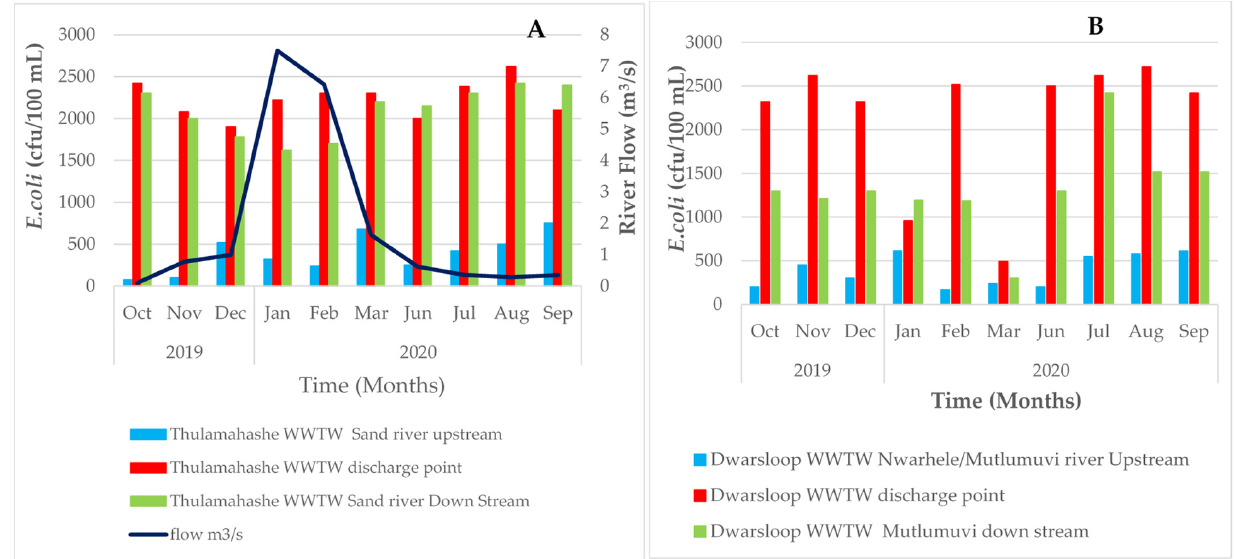
Figure 13. E. coli count in water resources ( A ) Sand River Catchment and ( B ) Mutlumivi River Sub Catchment.